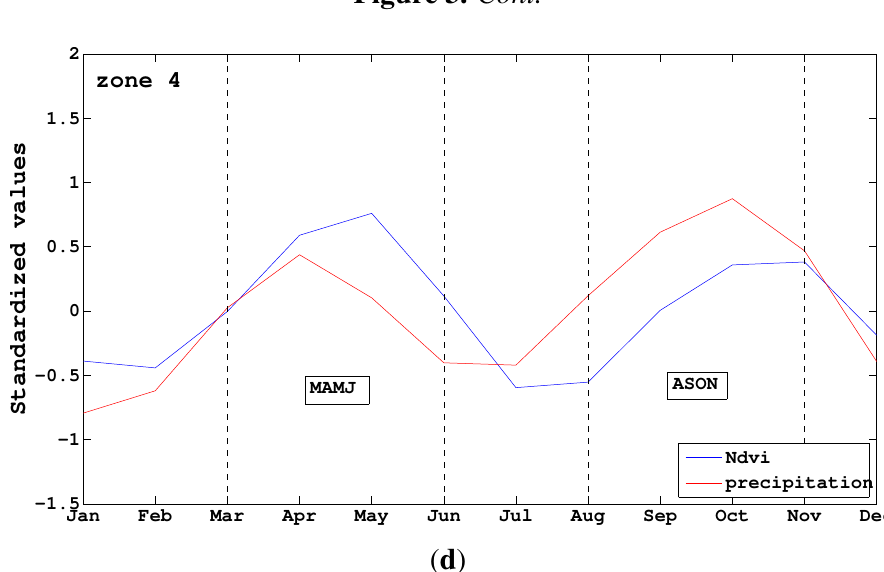
Figure 4. JJAS (June, July, August, September) seasonal variability of the monthly averages of NDVI (blue solid line) and precipitation (red solid line) for within 1982–2000 period over bioclimatic ecoregion zones 1 ( a ) and 2 ( b